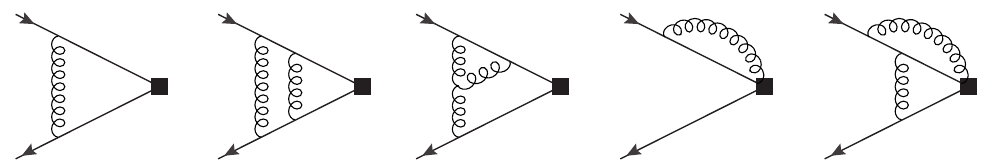
Figure 1 . Some representative Feynman diagrams for one- and two-loop corrections to the NRQCD ←→ LDME h 0 | χ † ( − i D ) ψ | Q ¯ Q i . Solid lines are heavy quarks and antiquarks, curly lines are gluons, 2 and filled squares represent the operator χ † ( − i